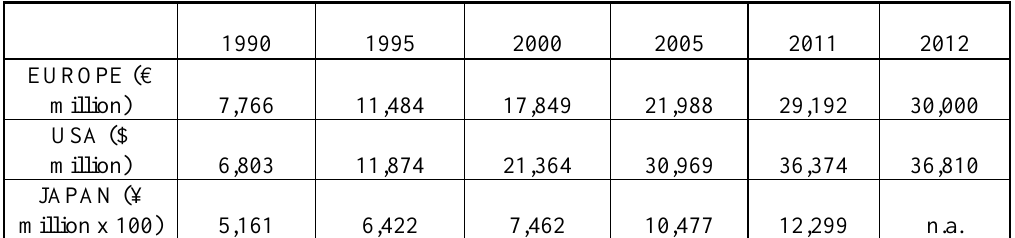
Table 4: Pharmaceutical R&D Expenditure in Europe, US, and Japan (Millions of National Currency Units). 1990-2012.